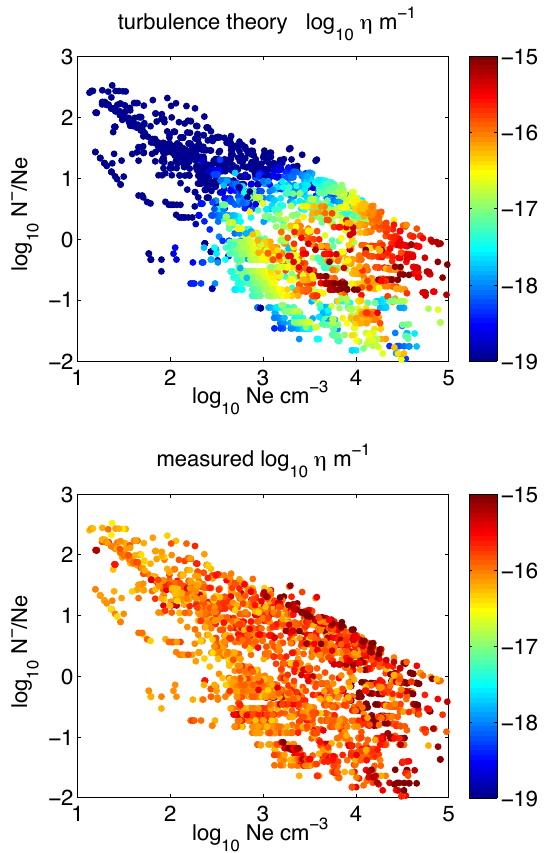
Figure 10. Theoretically expected and observed PMWE volume reflectivities as a function of modelled electron density and mod- elled ratio of negative ion to electron density. Theoretical esti- mates are for turbulence due to wind shear assuming a turbulent energy dissipation rate of 100mWkg − 1 and buoyancy frequency of 0.02rads − 1